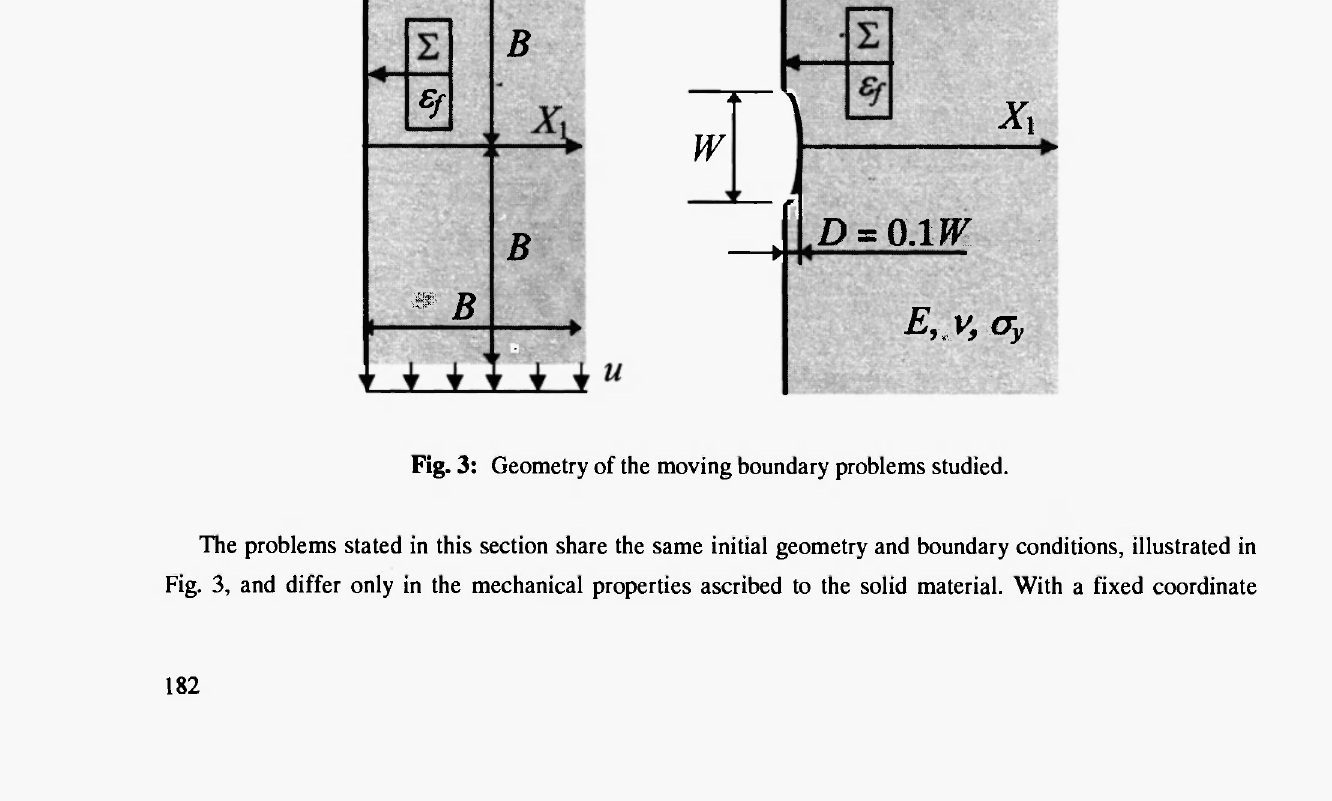
Fig. 3: Geometry of the moving boundary problems